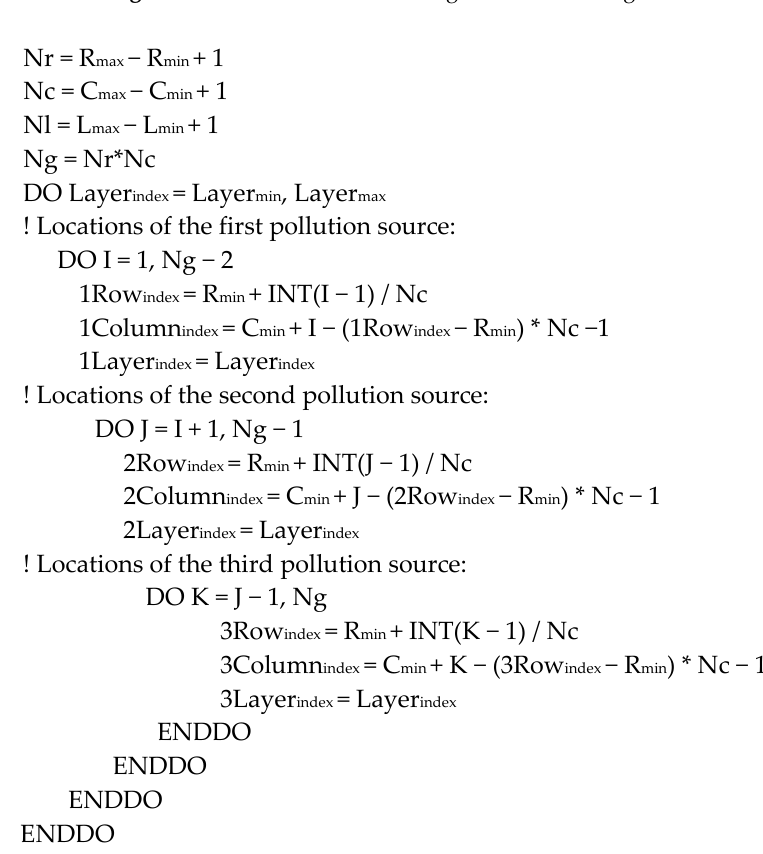
Figure 2. Illustration of the initial grid and the final grid.